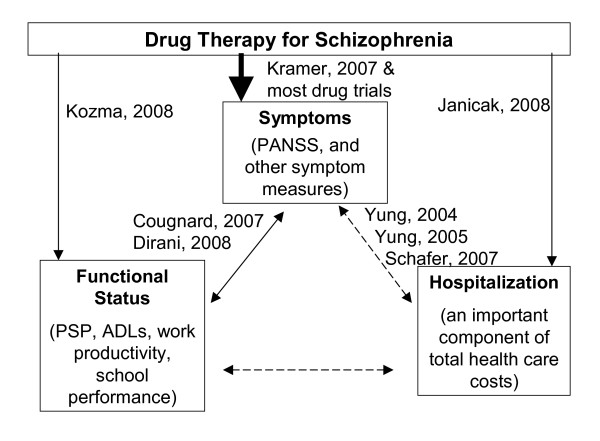
A partial listing of studies that have reported the relationship between symptoms, functional status, and hospitalization and how those outcomes are influenced by drug therapy. The dotted line relationships are the focus of this research.